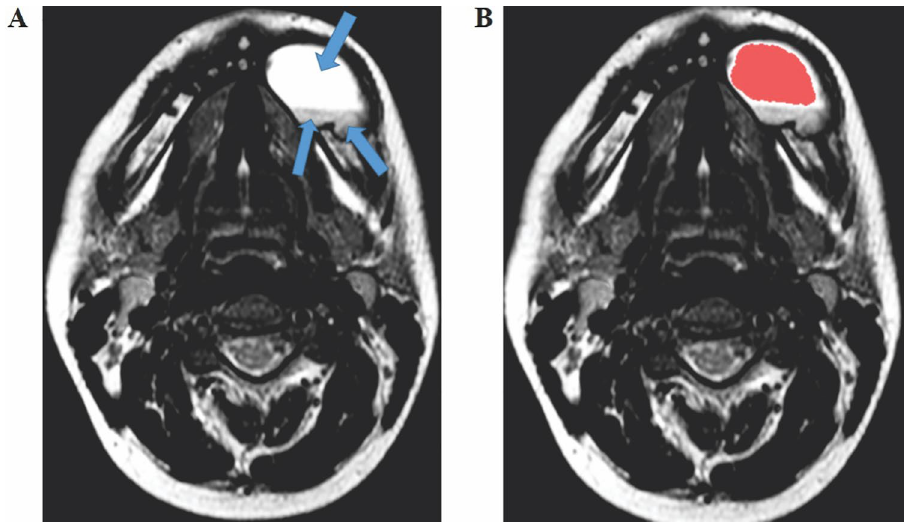
Figure 1. ( A ) Ameloblastoma located in the mandibular body on the left side. Arrows represent regions with variable signal intensity, which are characterized by hypersignal representing higher aqueous content, a characteristic of T2-weighted sequences. ( B ) Segmentation process represented by the red contour. Only the most homogeneous portion of the lesion was segmented, that is, the region shown by the hypersignal.